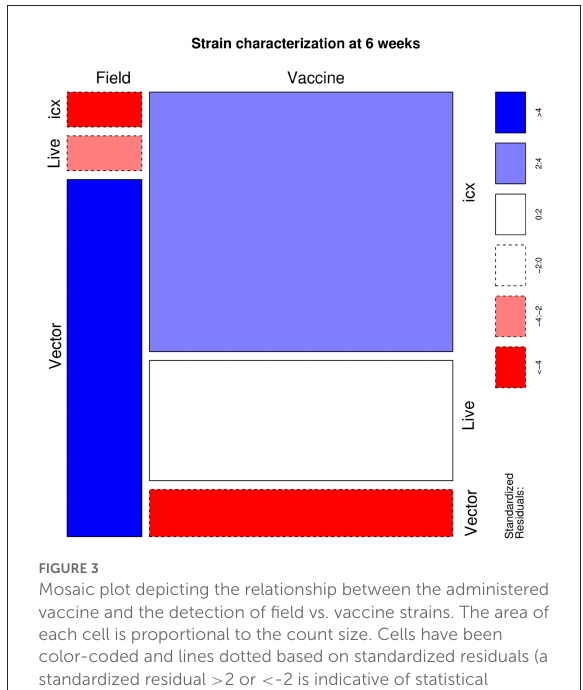
FIGURE3 Mosaic plot depicting the relationship between the administered vaccine and the detection of field vs. vaccine strains. The area of each cell is proportional to the count size. Cells have been color-coded and lines dotted based on standardized residuals (a standardized residual > 2 or < -2 is indicative of statistical